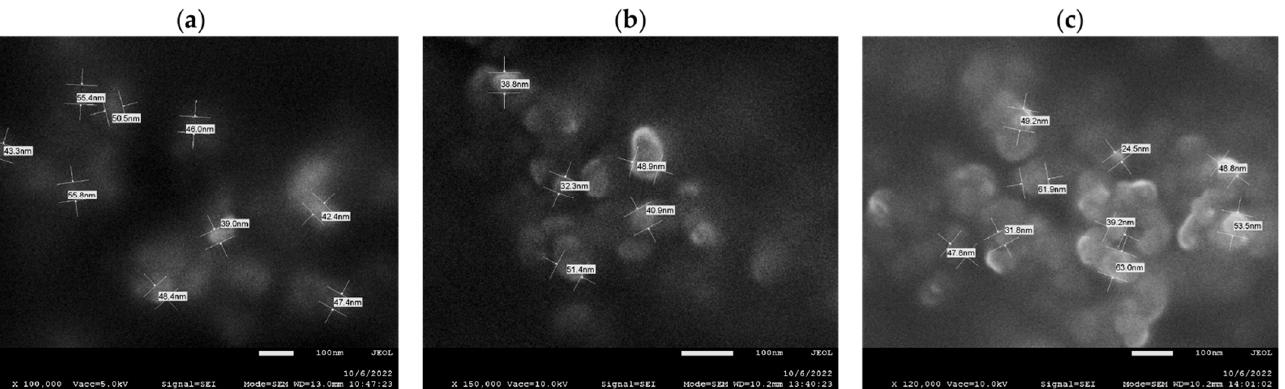
Figure 4. Mechanism of action of dimeric imidazolium ionic liquids against the applied cellulosic material.